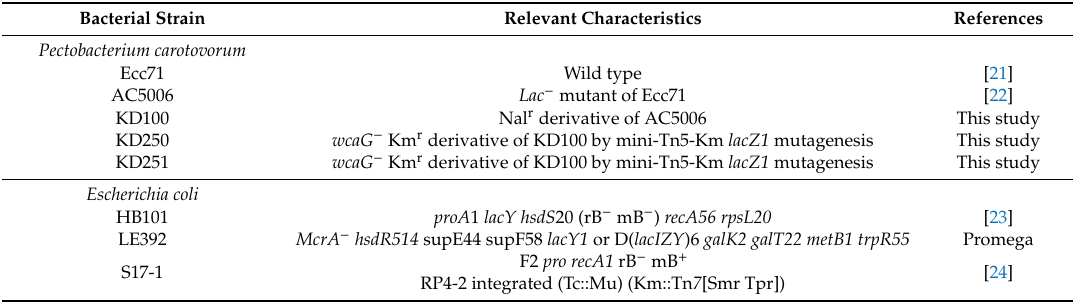
Table 1. Bacterial Strains or